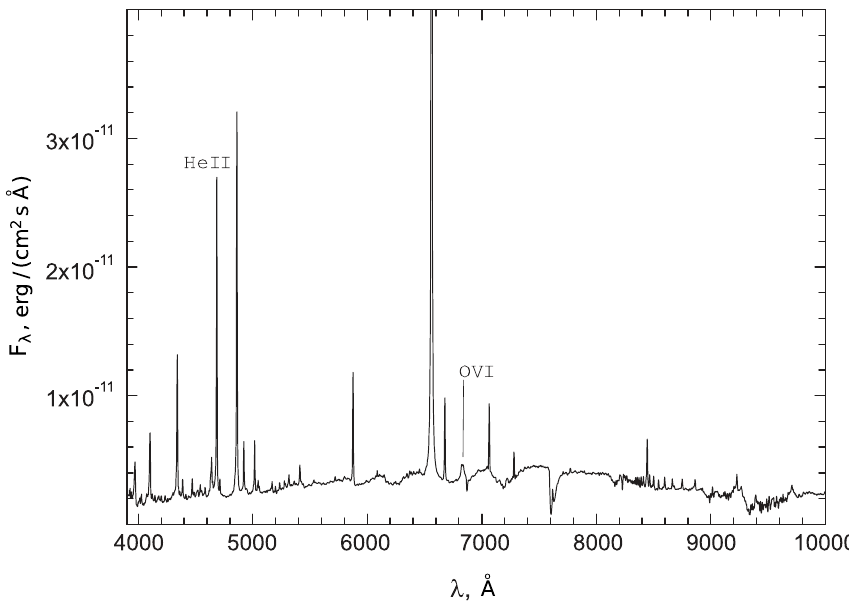
Fig. 4. Spectrum of AG Peg taken on 2015 August 8, during an outburst.